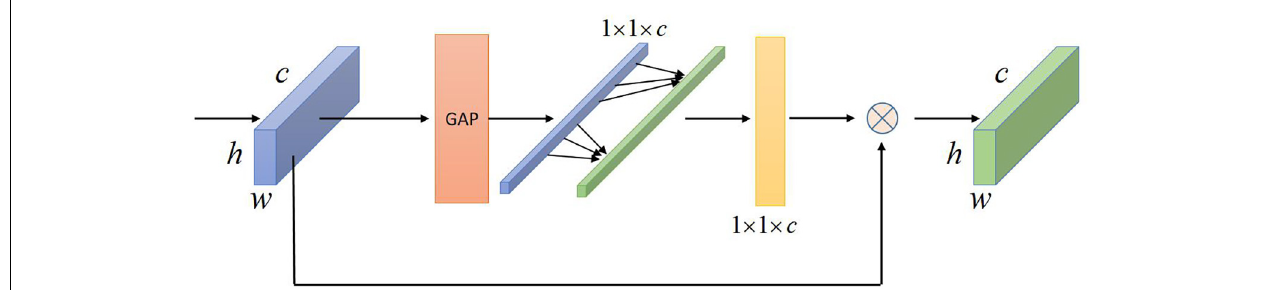
FIGURE 2 | Schematic diagram of the channel attention model.